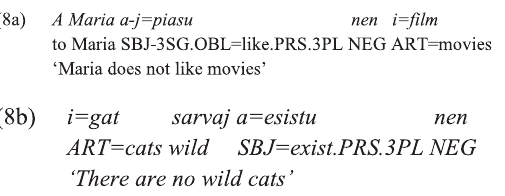
Frontiers in Communication |